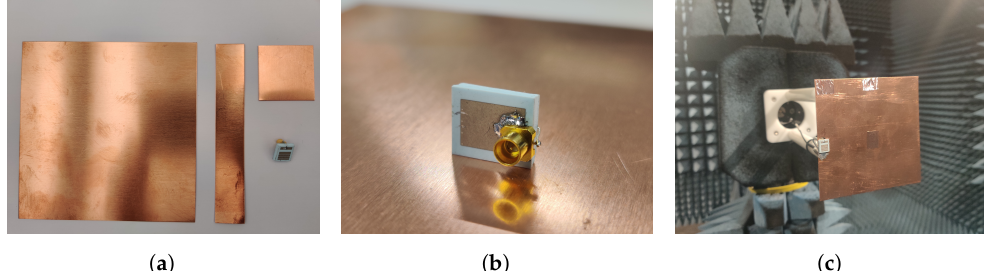
Figure 3. Pictures of the ( a ) analyzed ground planes manufactured with copper sheets and the fabricated antenna, ( b ) antenna with connector, ( c ) measurement set-up in the anechoic